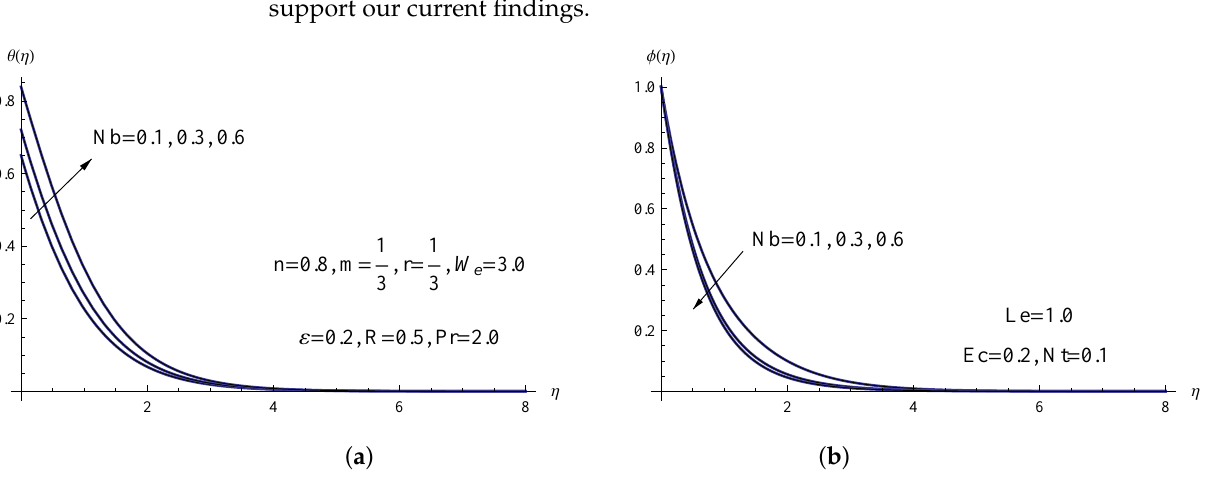
Figure 8. ( a ) θ ( η ) via Nb ; ( b ) φ ( η ) via Nb